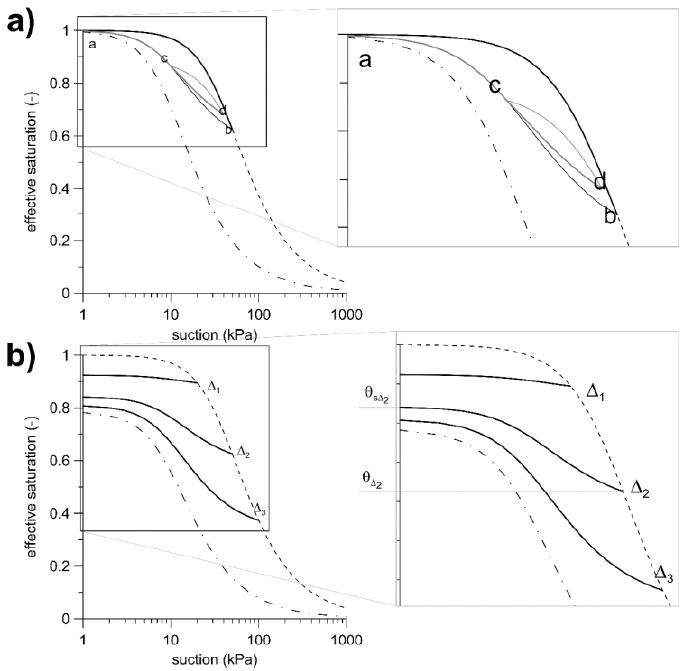
Figure 3. ( a ) Scanning path scenarios for the hysteretic PL model; ( b ) effect of air entrapment.